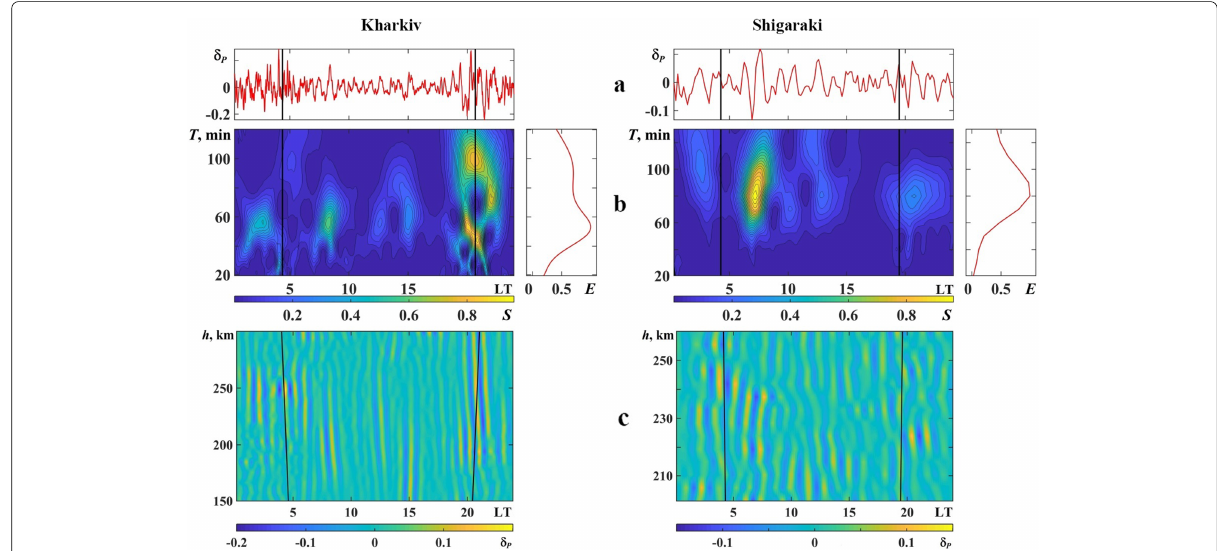
Fig. 5 Relative variations of incoherent scatter power δ P ( a ) measured by KhISR at the altitude of 200 km (left) and MUR at the altitude of 220 km (right) as well as corresponding results of spectral analysis ( b ) and band-pass filtering ( c ). Subfigure ( b ) contains a power spectral density S indicated by color level plotted vs time and period as well as average power E plotted vs period. Both S and E values were normalized to their maximums. Subfigure ( c ) shows altitude-time plots of δ P band-pass filtered in the range of 40–80 min and 60–120 min for KhISR and MUR data, respectively. The solid lines mark the time of local sunrise and sunset terminator passage at the current altitude. LT is solar apparent